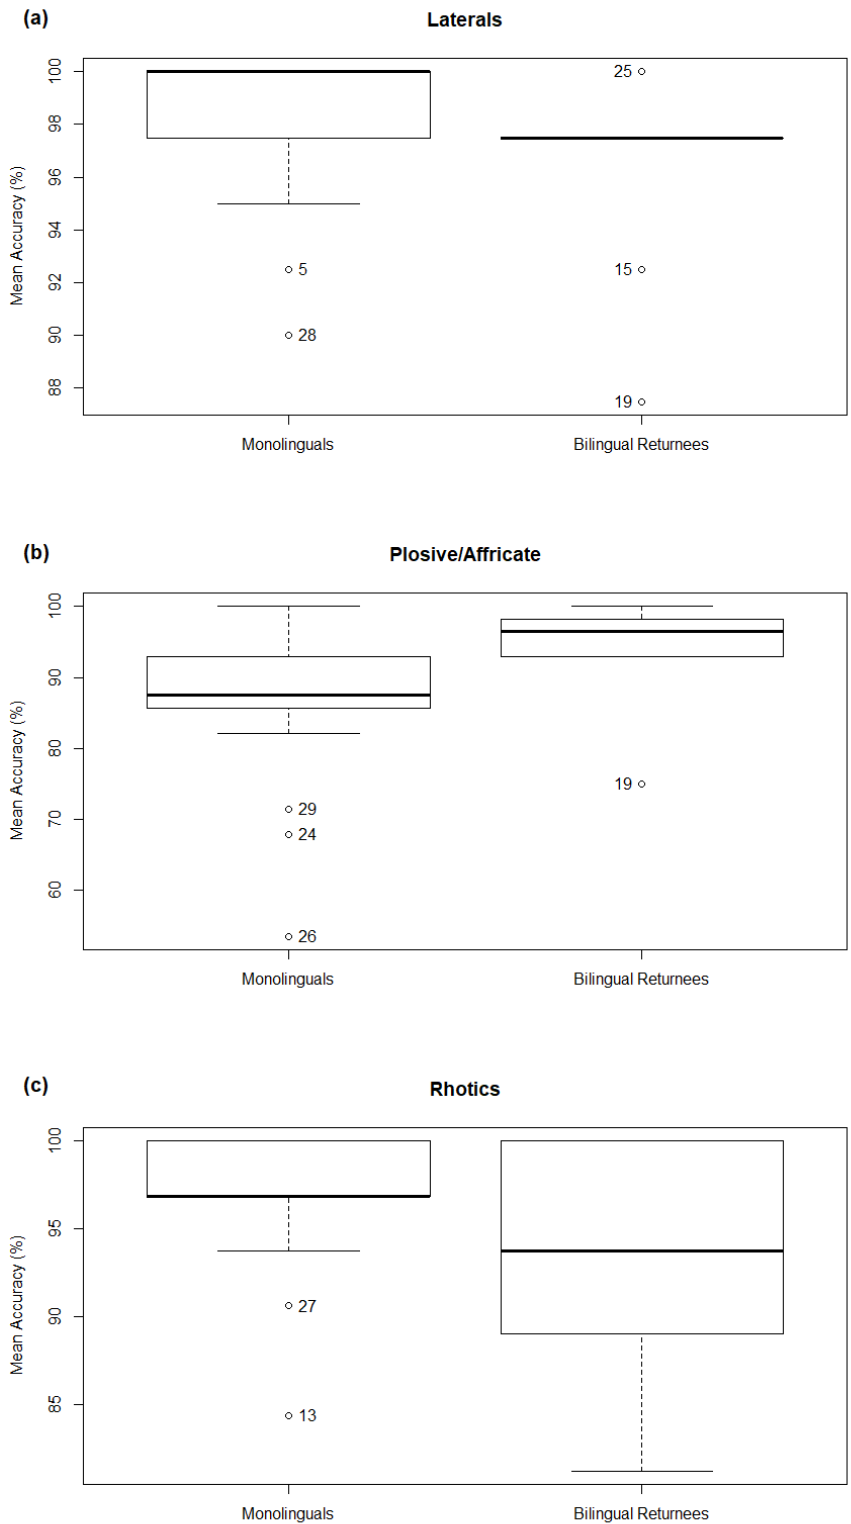
Figure 3. Boxplots depicting accuracy rates for each of the three contrasts: ( a ) shows percentage accuracy in the identification of /l/ versus / ɫ /; ( b ) /c/ versus / ʧ /; ( c ) / ɹ / versus /r/. In each panel, monolinguals and bilingual returnees are shown separately. Outlier participants are also displayed in each panel.